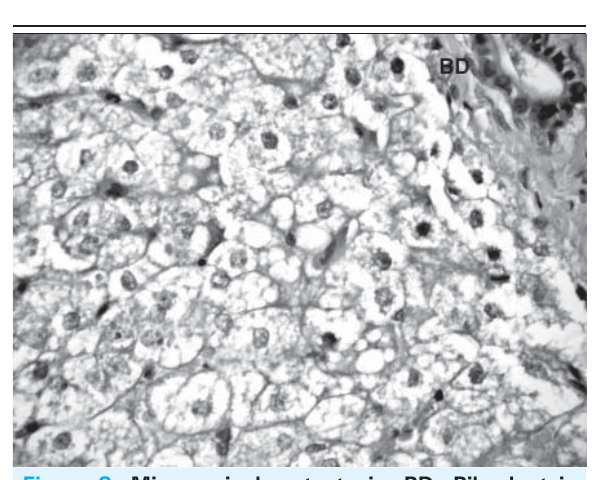
Figure 3. Microvesicular steatosis. BD, Bile duct is normal. H&E,